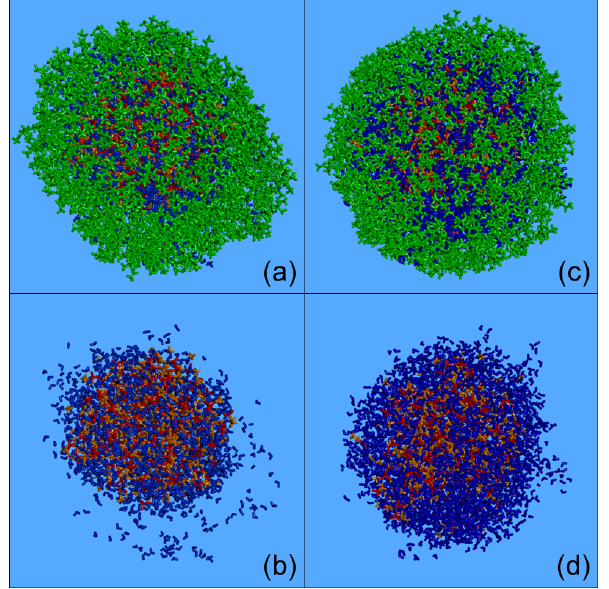
Figure 9. Characteristic snapshots from the MD simulations of the nanoparticles containing CPA (74% dry): (a) at 76% RH includ- ing CPA molecules, (b) at 76% RH omitting CPA molecules, (c) at 89% RH including CPA molecules and (d) at 89% RH omitting CPA molecules. Colour coding: green for CPA, red for sulfate, or- ange for ammonium and blue for water.